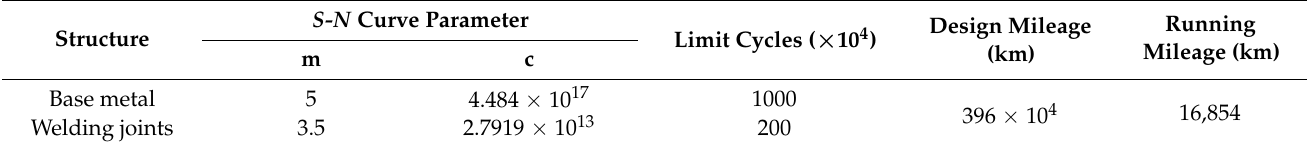
Table 6. Fatigue parameters of bogie frame material.